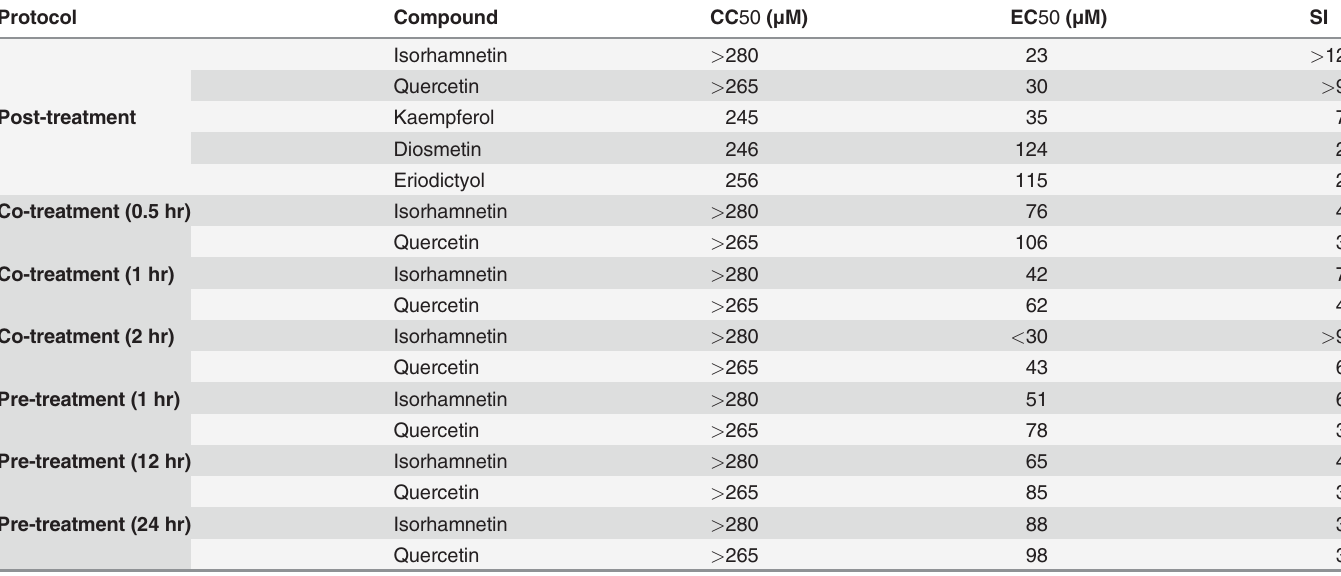
Table 1. Representation of the antiviral activities of isorhamnetin and other flavonoids by SI.